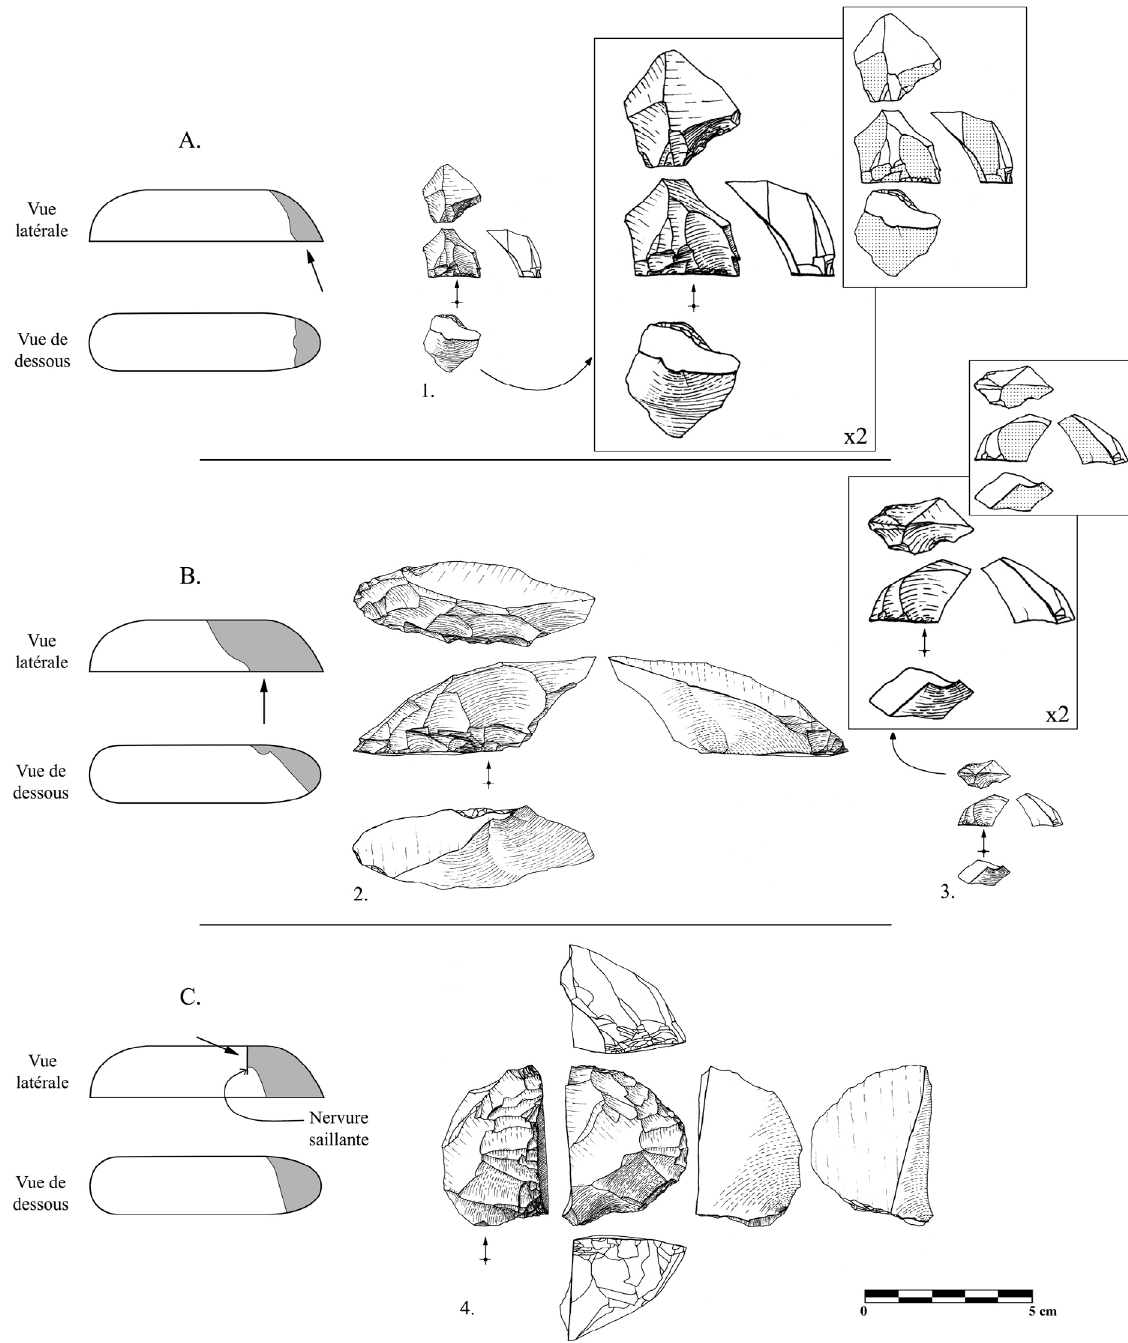
Figure 3. Procédés de raffûtage de pièces façonnées unifacialement par enlèvement complet d’une extrémité. A : coup porté à l’extrémité, sur la face plane et dans l’axe longitudinal ; B : coup porté sur la face plane, au niveau d’un bord, à proximité de l’extrémité ; C : coup tangentiel à la surface de la pièce porté sur la face non plane sur une nervure saillante à proximité de l’extrémité. Les pièces 1 et 3 présentent une double patine (patine récente en surfaces pointillées sur les schémas) attestant de raffûtages antérieurs plus légers (1) et d’un premier essai avorté de retrait de l’extrémité (3). Figure 3. Resharpening processes of unifacially shaped artefacts by removing an end. A: blow to the end, on the plane surface and in the longitudinal axis; B: blow to the plane surface in one side, near the end; C: tangential blow to a prominent ridge on the non-plane surface, near the end. Artefacts 1 and 3 have a double patina (recent patinas are represented by dotted surfaces in the drawings) that demonstrate resharpening (1) and a first aborted tentative of removal of the end